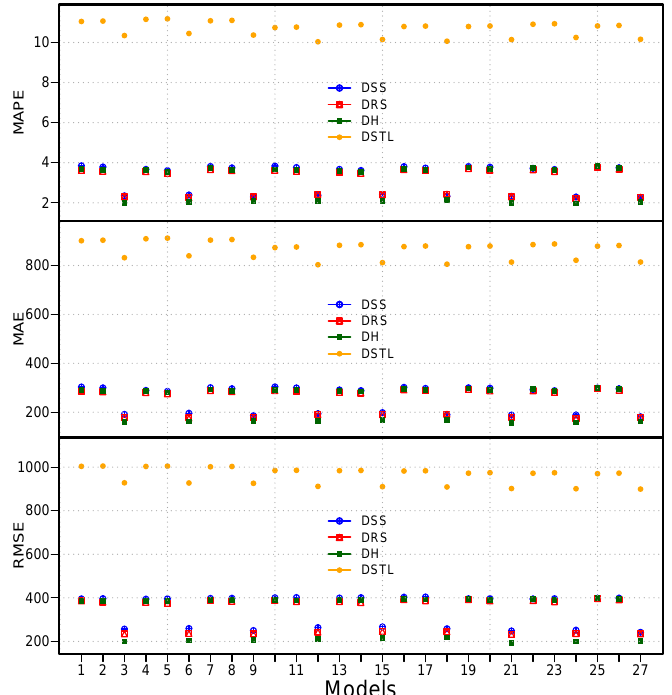
Figure 3. Performance measures: the MAPE ( top ), MAE ( center ), and RMSE ( bottom ) for all combi- nation models using three proposed and the benchmark decomposition methods.